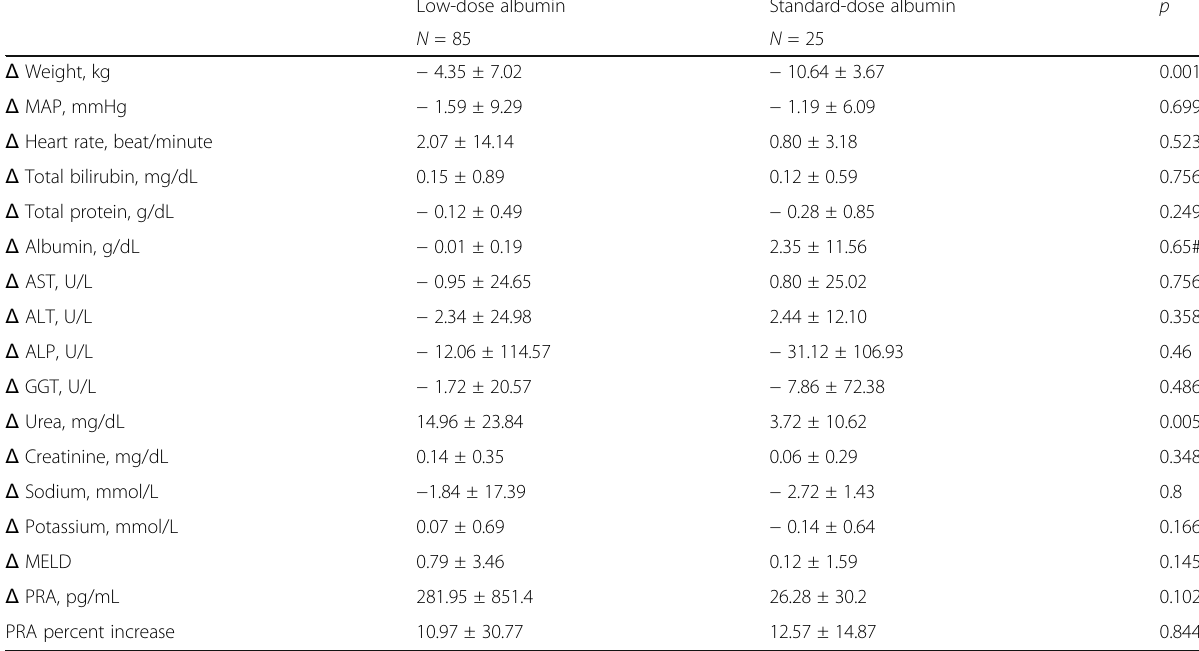
Table 2 Comparison of treatment induced changes in both groups Low-dose albumin Standard-dose